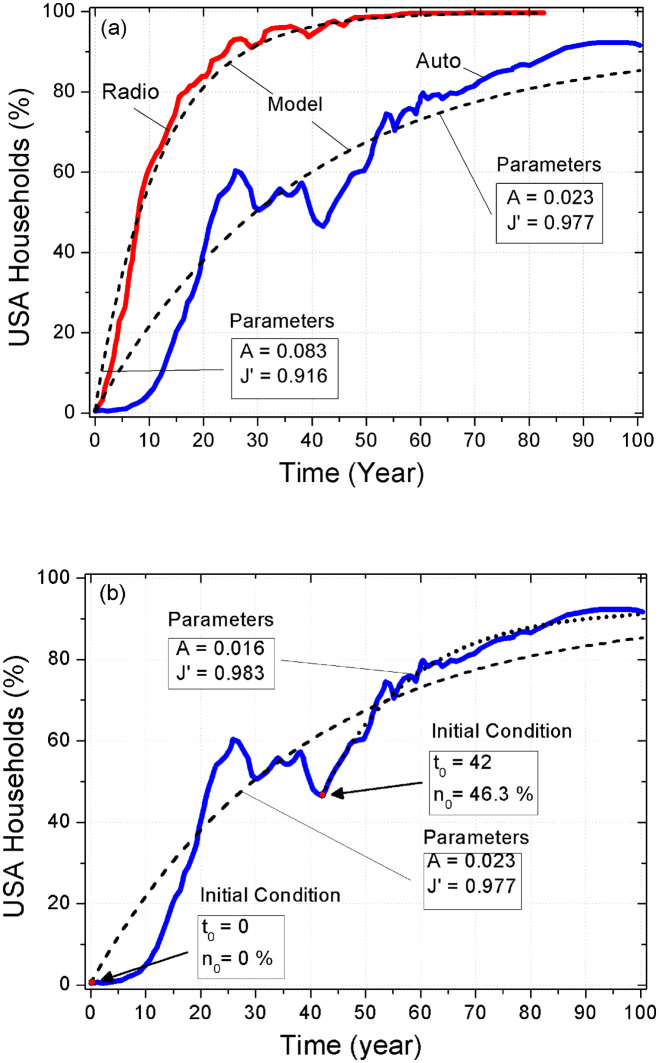
Dynamics of adoption of new technologies by American households, according to the data of Felton [21].Continuous lines correspond to Felton’s data for two selected innovations, radio and automobile. Dashed lines correspond to the best fit using analytic solution Eq 19 with initial conditions n(t0) = n0. (a) Adoption of radio and automobile are represented from the inception of the innovations, i.e. with n(0) = 0. The adjustment is much better for radio than for car, because of the big fluctuations of car production during World War II. (b) Automobile adoption using two different starting points, n(0) = 0 (dashed line, with year 0 corresponding to calendar year 1903) and considering a new beginning after the World War II, n(42) = 0.463 (dotted line, with year 42 corresponding to calendar year 1945). The fit after the World War II is much better than for the full time-lapse. ω ≃ 1 for both technologies.